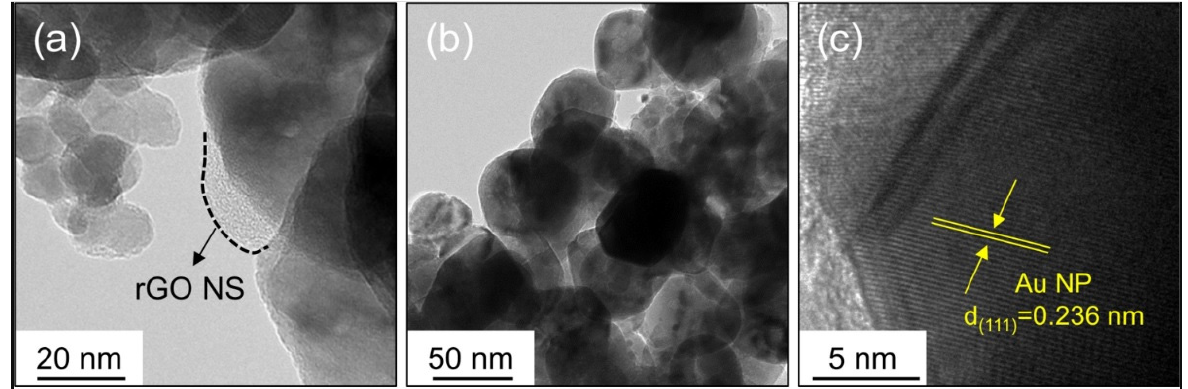
Figure 8. ( a )TEM imageof Au-functionalized rGO-loaded ZnO NF. ( b ) TEM image of a ZnO NF. ( c ) Lattice-resolved TEM image of Au-functionalized rGO-loaded ZnO NF [60].